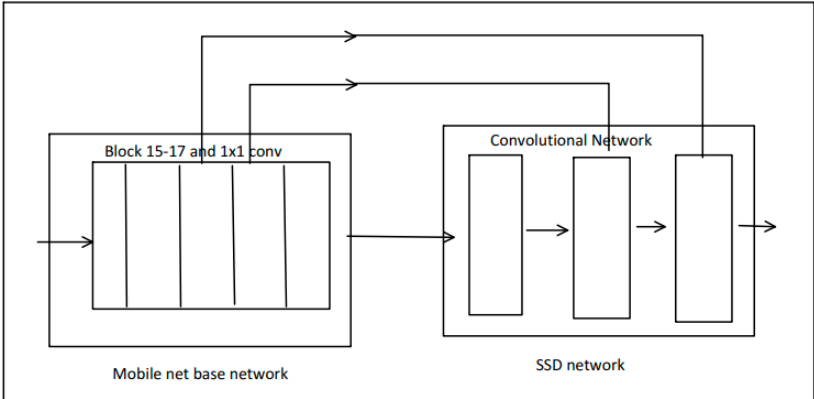
Figure 2. Pose-Net architecture.